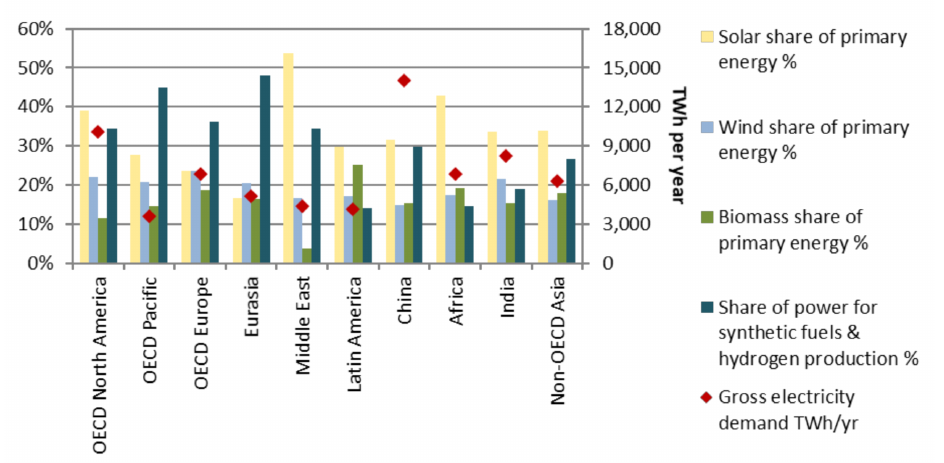
Figure 2. Selected regional characteristics of energy demand and supply in the 1.5 ◦ C Scenario in